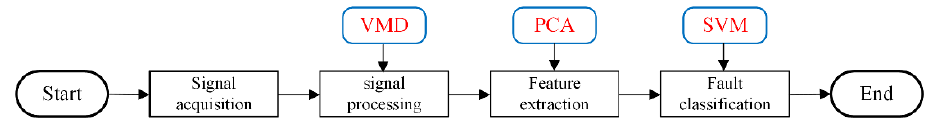
Figure 1. Main framework of the proposed BearingCog.